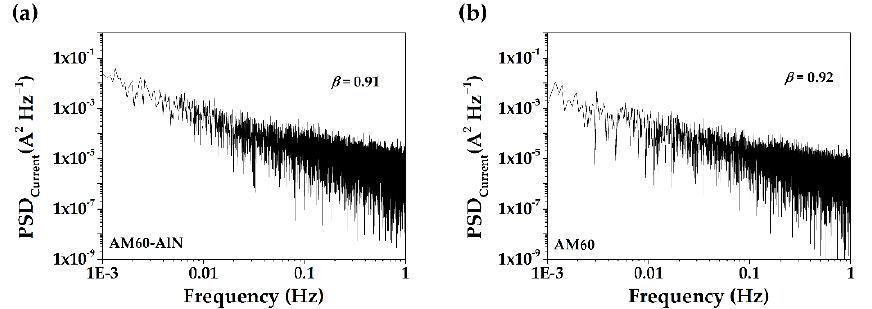
Figure 6. Power spectral density (PSD) plots of AM60-AlN ( a ) and AM60 ( b ) corrosion current fluctuations at 30 days of exposure to a simulated marine environment solution.